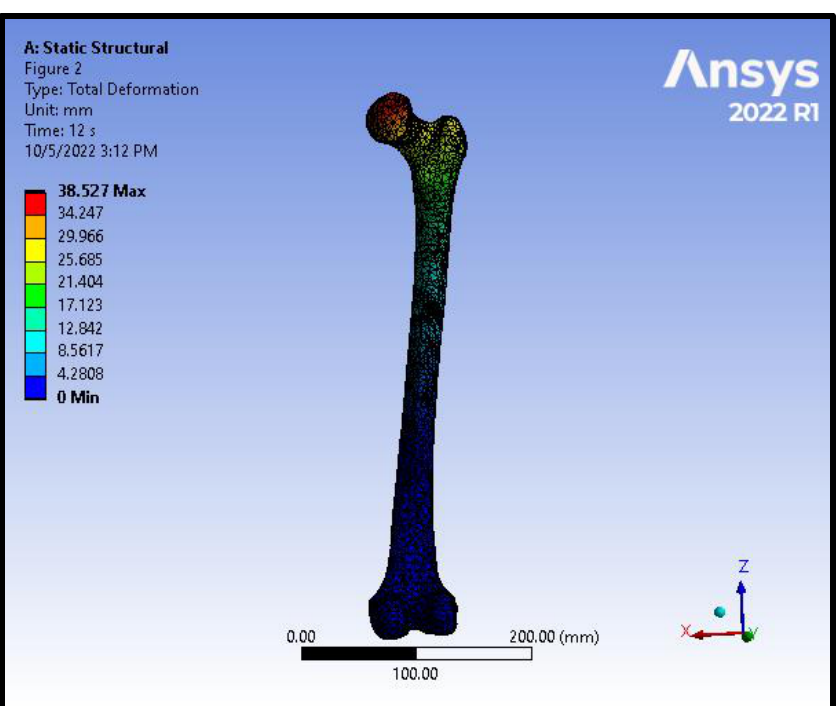
Figure 7. von Mises stress distribution on the femoral model in an intracapsular fracture under axial compression and torsion scenario.